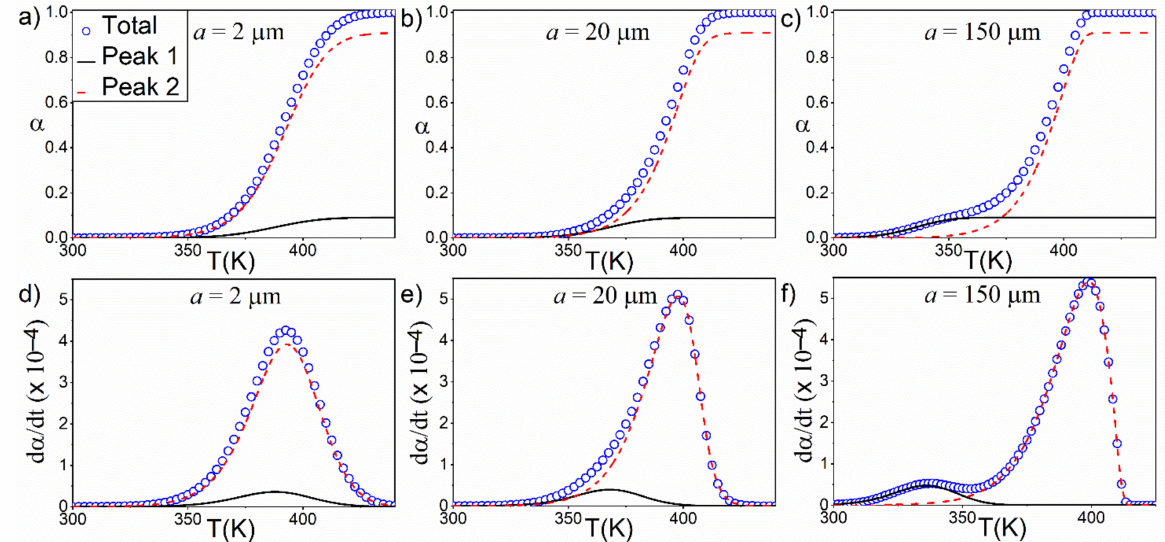
Figure 7. ( a – c ) Curves of α as a function of temperature, simulated using the R3 kinetic models modified by bimodal PSD, with β = 1 K · min − 1 and a = 2, 20 and 150 µ m, respectively. ( d – f ) Derivative of α with time as a function of temperature for a = 2, 20 and 150 µ m, respectively.